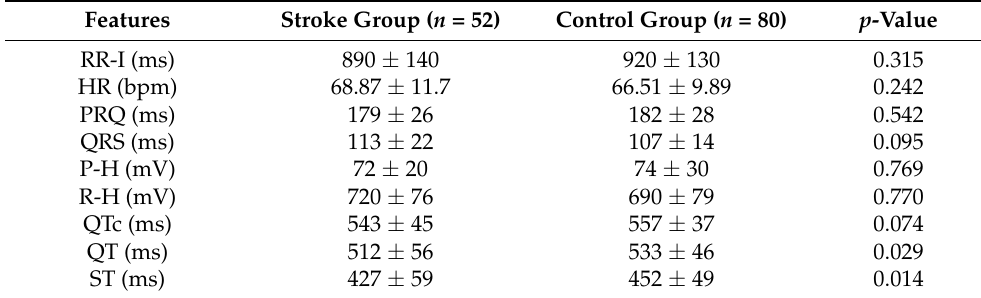
Table 4. Fiducial features of the electrocardiogram